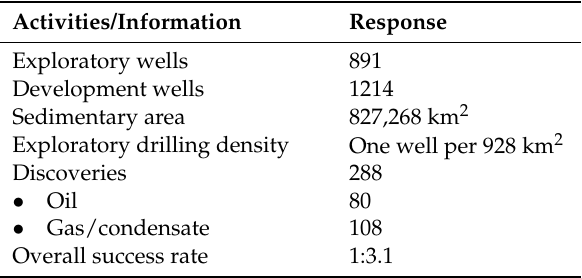
Table 3. Summary of oil and gas exploration activities as on 1 July